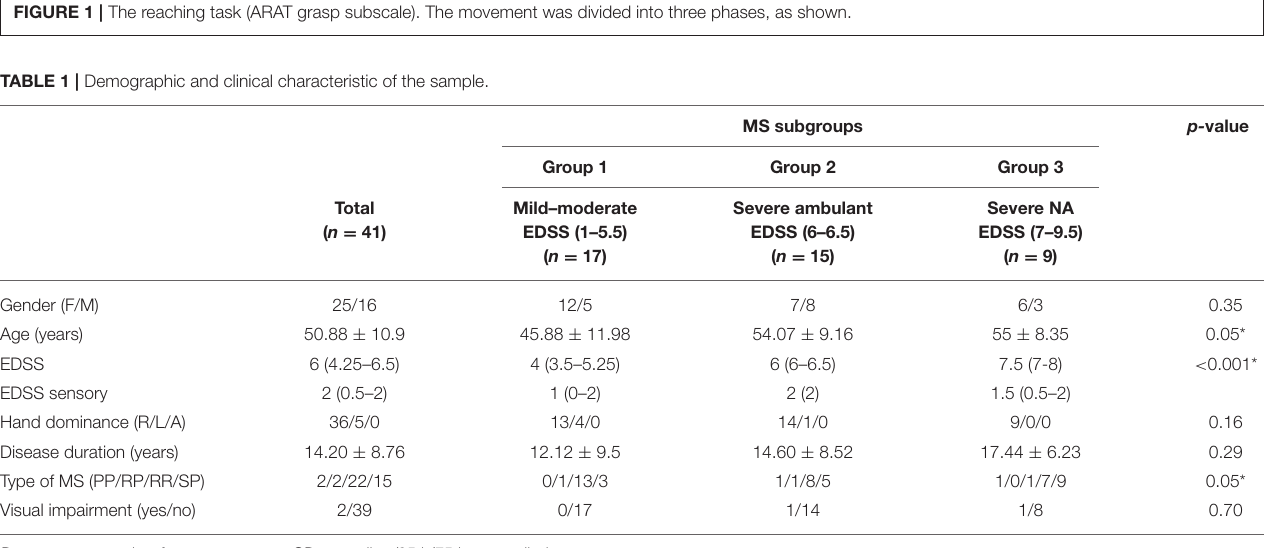
FIGURE 1 | The reaching task (ARAT grasp subscale). The movement was divided into three phases, as shown.